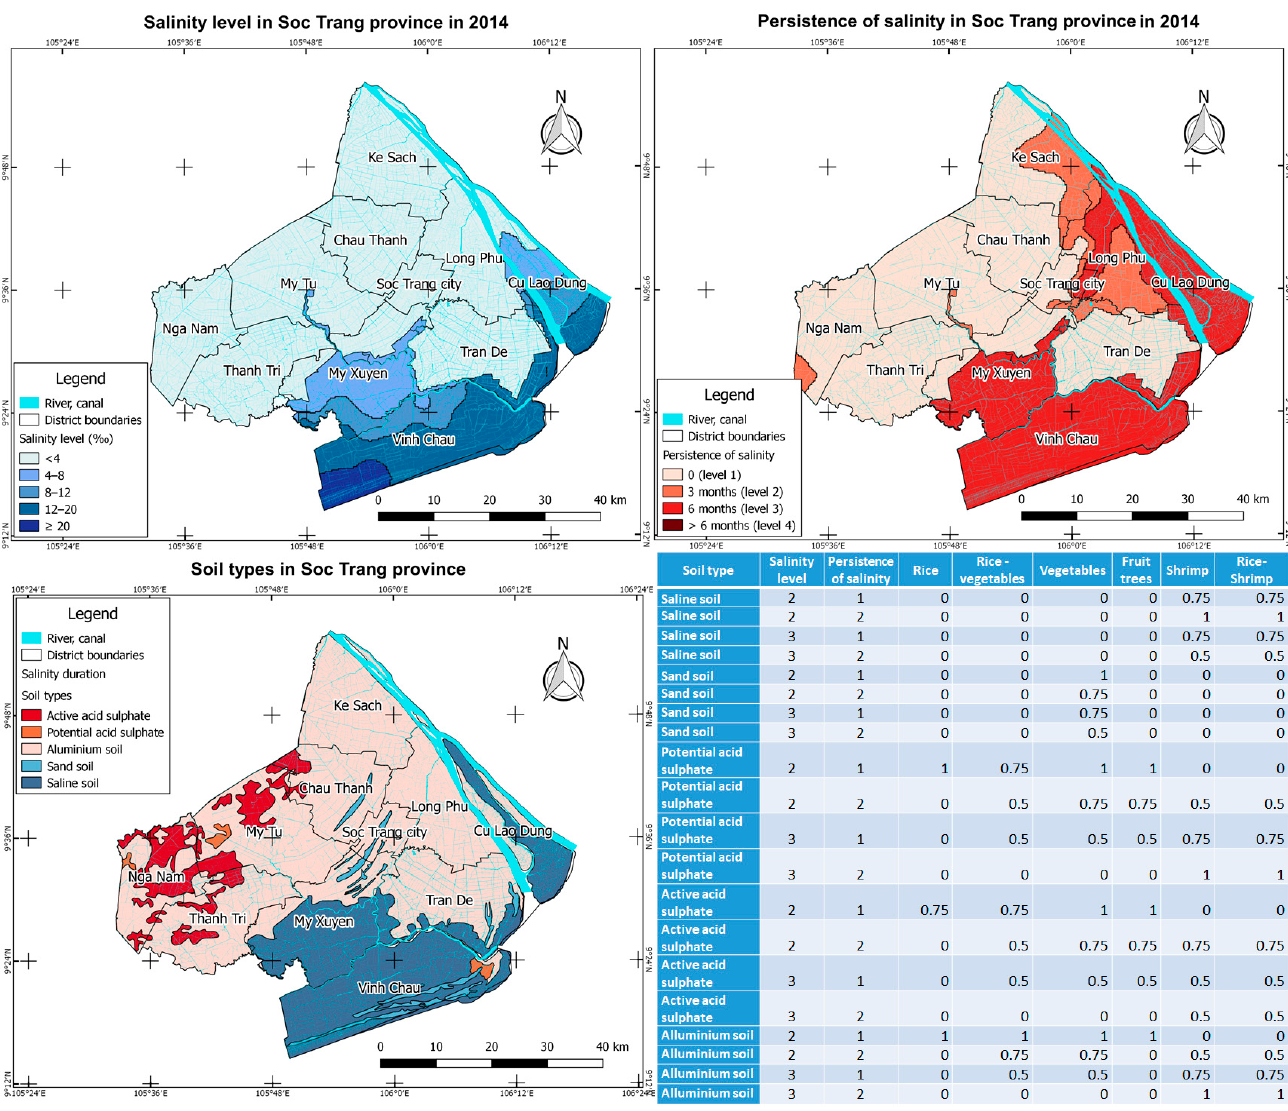
Figure 4. Input layers for land-suitability evaluation. (Source: Department of Land Resources, 2014 [40]).